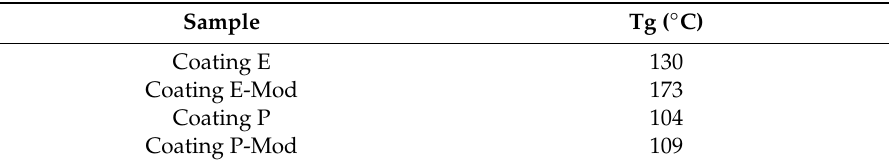
Table 6. Tg values of the 4 samples series.